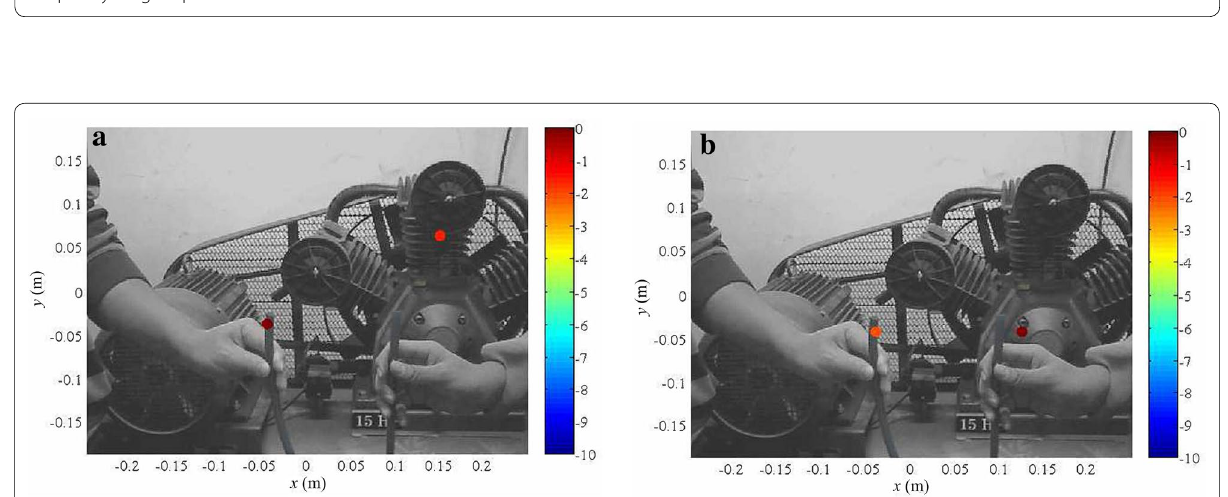
Figure 13 Source maps for the gas leakage experiment are obtained by: a )DCS-SOMP method, and b DCS-SOMP-SVD method when the frequency range equals 3500 ‒ 4000 Hz